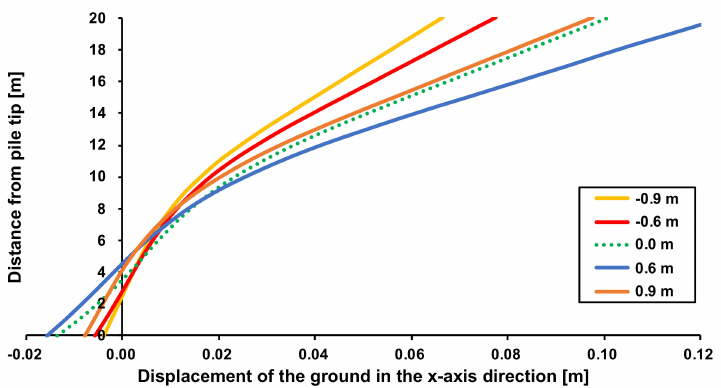
Figure 13. Displacements of new pile when installing position is shifted by ± 0.6 m and ± 0.9